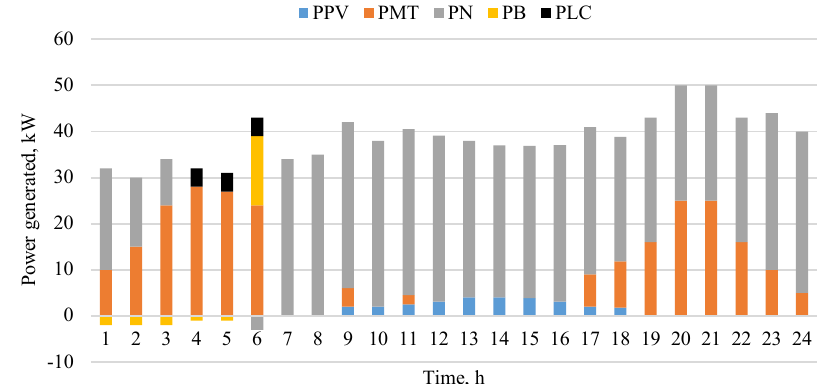
Fig. 5. Output power of each components and network in scenario 1.